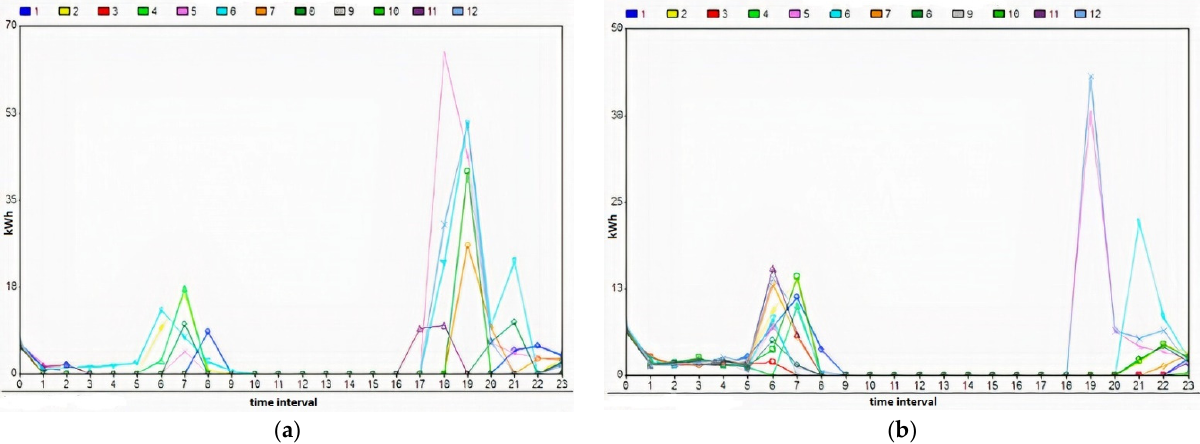
Figure 4. ( a ) Daily energy imported to the micro-grid for every month for case study I; ( b ) Daily energy imported to the micro-grid for every month for case study II–III.